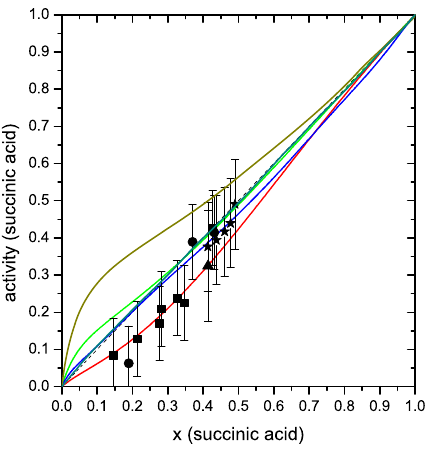
Fig. 8. Succinic acid activity versus mole fraction. Data at T = 278 . 8K: F , T = 283 . 2K: , T = 290 . 9K: (cid:4) , T = 298 . 4K: N . Dotted line: Raoult’s law; Dark yellow line: UNIFAC Dortmund parameterization taken from Koponen et al. (2007); Dark cyan line: van Laar parmeterization by Koponen et al. (2007); Green line: UNIFAC parameterization by Ming and Russell (2002); Blue line: parameterization by Clegg and Seinfeld (2006a) ∗ ; Red line: UNI- FAC parameterization Peng et al. (2001). Mole fractions are on the basis of undissociated succinic acid. ∗ See footnote to Fig. 2.